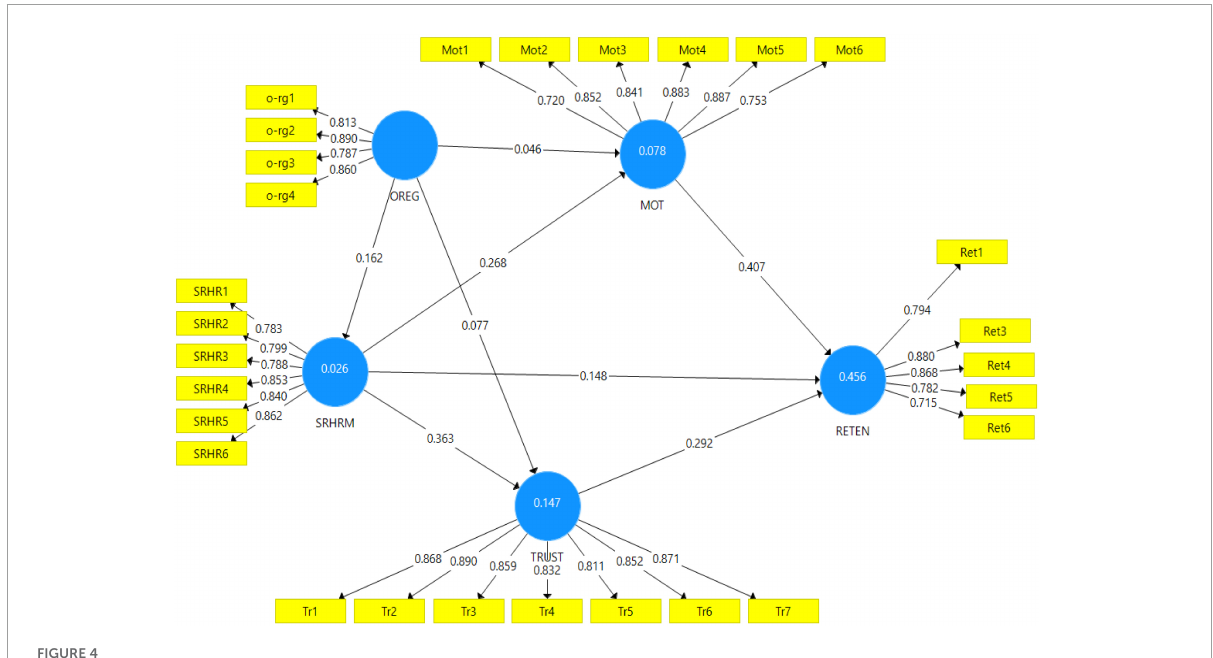
FIGURE4 The measurement model after